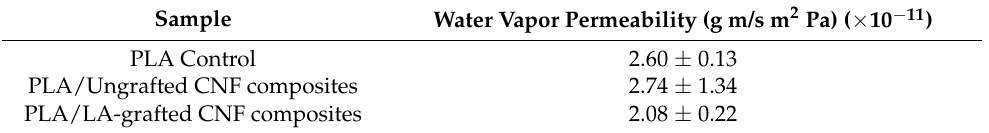
Table 5. Water vapor permeability PLA composite films containing either 2% ungrafted CNF or 2% LA-grafted CNF.